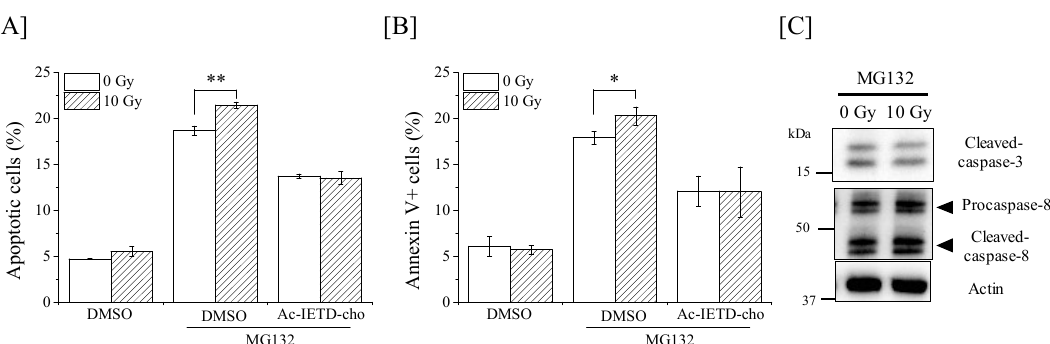
Figure 6. Effects of co-treatment with MG132 and ionizing radiation on apoptosis induction in macrophages. ( A , B ) Ac-IETD-cho or DMSO were added to the culture medium 1 h before the addition of MG132. One hour after the addition of MG132 (1 µM), the cells were exposed to 10-Gy X-ray irradiation. The cells were cultured for 24 h and harvested for the detection of apoptosis and cell death analyses. Data are presented as the mean ± SD of three independent experiments. * p < 0.05, ** p < 0.01. ( C ) MG132 (1 µM) were added to the culture medium 1 h before 10-Gy X-ray irradiation. The cells were cultured for 24 h and harvested for Western blot analyses of caspase-3 and -8. The expression of β-actin was analyzed as a loading control.